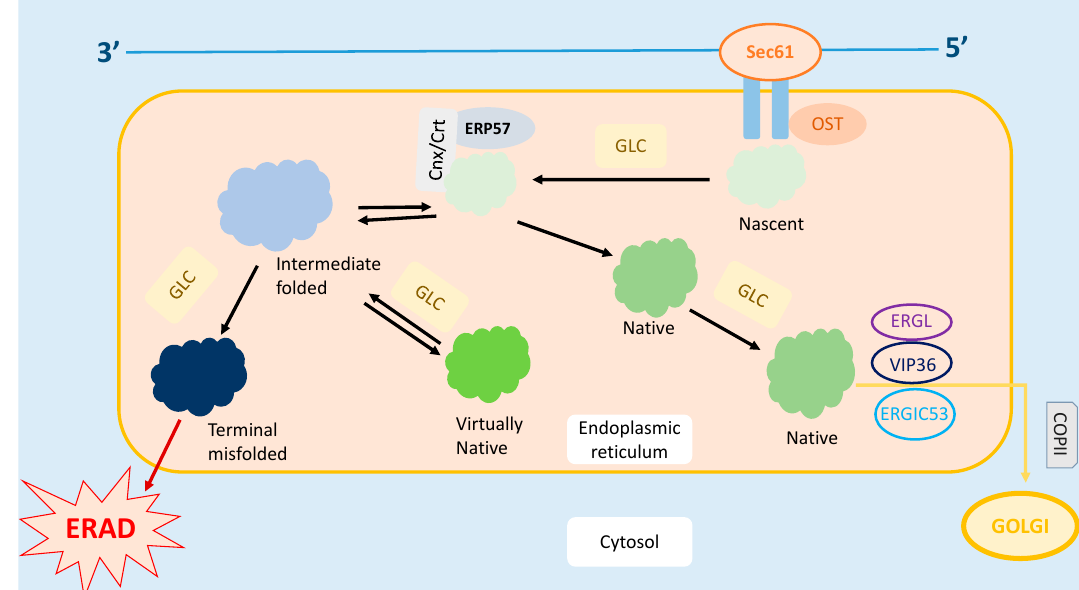
Figure 1. Protein trafficking in ER. Post mRNA translation, the nascent protein is transferred into the ER via the Sec61 channel, followed by the OST-mediated addition of N -acetylglucosamine residue on the protein. Glucose present on the oligosaccharide core undergoes glycosylation. The protein is then folded, and the disulfide bond is formed within the protein to stabilize its structure. Further, the correctly folded protein is cleaved and transported to the Golgi apparatus for further modifications. On the other hand, the misfolded protein rebinds to Cnx/Crt and is subjected to the refolding process. However, if the protein is recognized as terminally misfolded, it will be removed from the ER and subjected to ER-Associated Degradation (ERAD). * Cnx, Calnexin; COPII, Coat Protein II; Crt, Calreticulin; EDEM, ER Degradation Enhancer- α -Mannosidase; ERGIC53, ER-Golgi Intermediate Compartment 53 kDa Protein; ERGL, ERGIC53-like Protein; Erp57, ER-located PDI 57 kDa Protein; GlcI, Glucosidase I; GlcII, Glucosidase II; OST, Oligosaccharide transferase; UGTI, Uridine Diphosphate Glucose:glycoprotein Glycosyltransferase; VIP36, Vesicular Integral-membrane Protein 36.